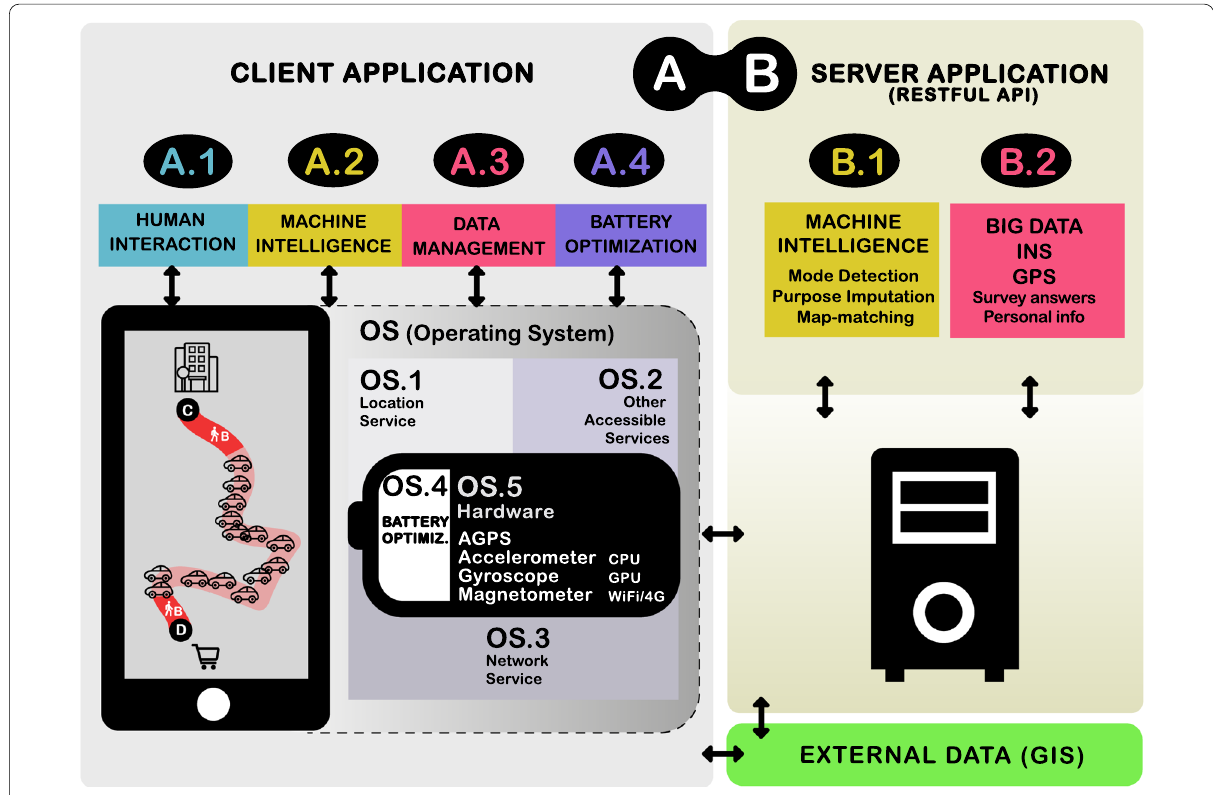
Fig. 2 Smartphone-based travel survey platform